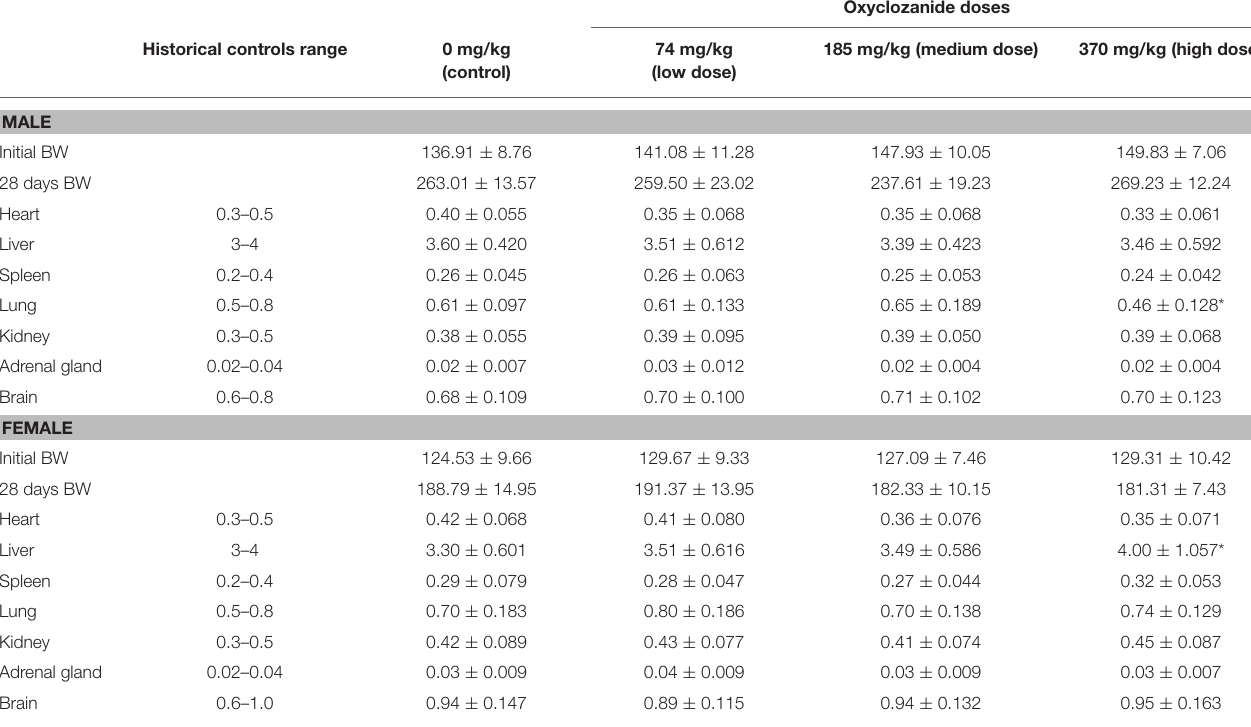
TABLE 4 | Effect of oxyclozanide on the body and relative organ